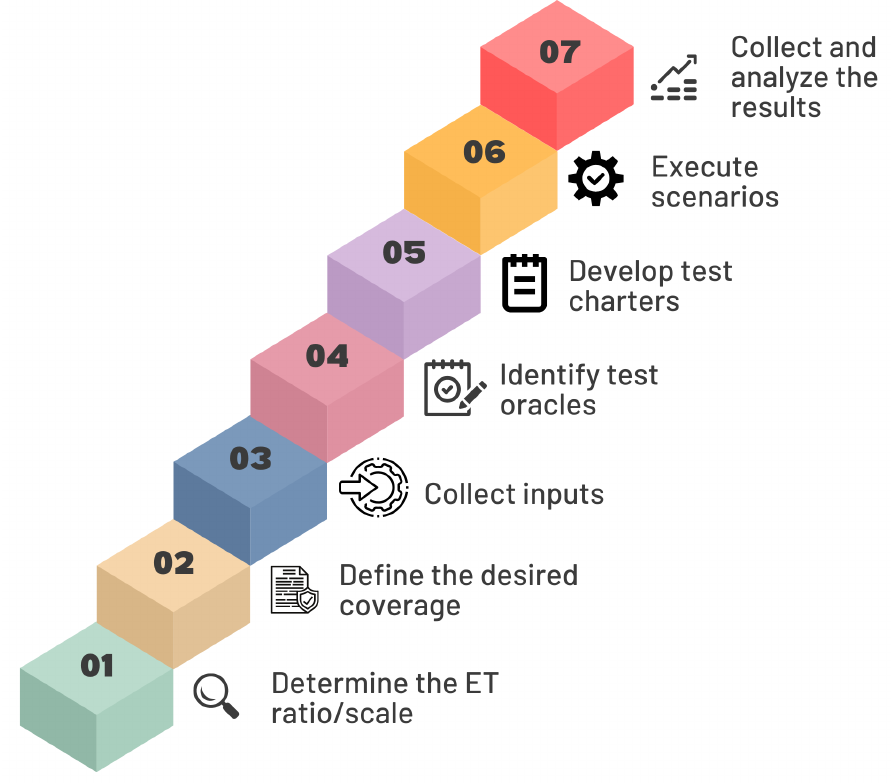
Figure 2. Exploratory testing framework